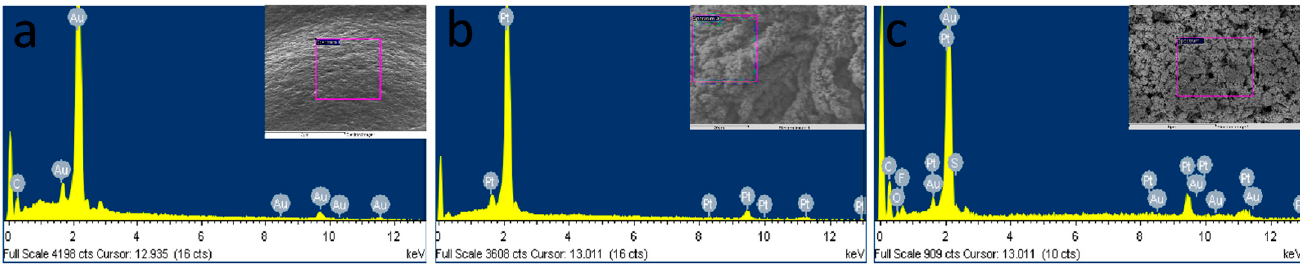
Figure 5. SEM/EDX characterization of the bare AuMN ( a ), AuMN/Pt-black ( b ) and AuMN/Pt- black/Nf electrodes ( c ).